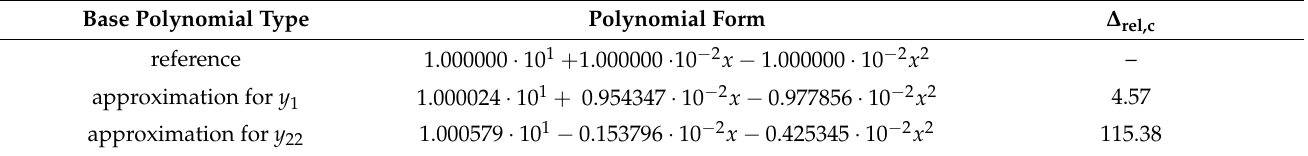
Table 3. The results of the first part of the experiment assuming D 1 = 7 and POb = POa = 2 on the example of dependences for which the greatest relative errors of the coefficients were